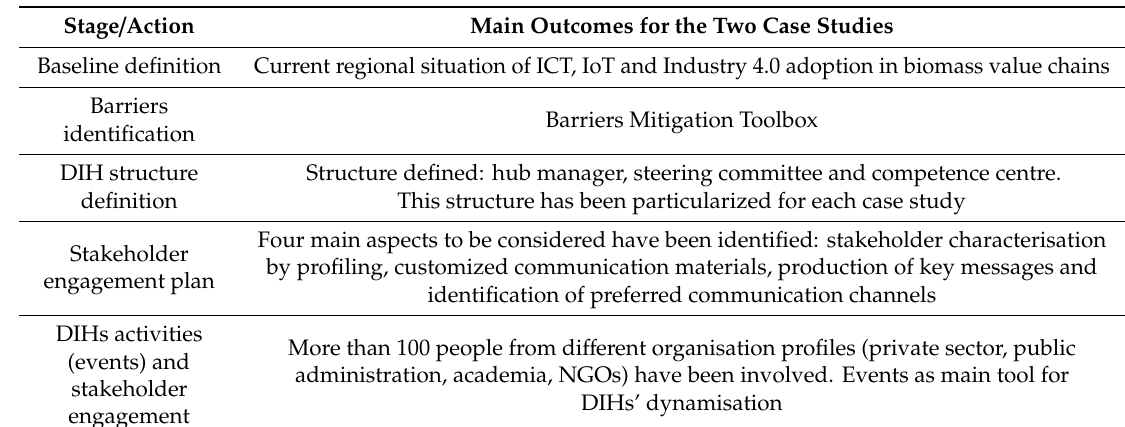
Table 1. Summary of main outcomes of the proposed approach for DIHs’